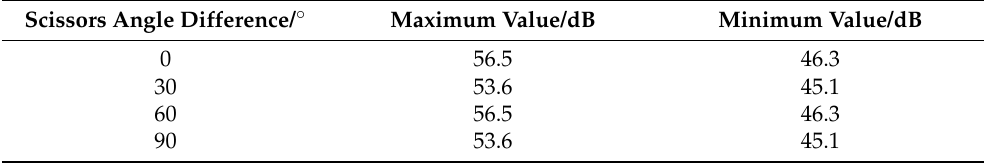
Table 7. Maximum and minimum SPL values at an azimuth angle = 180 ◦ in helicopter mode.